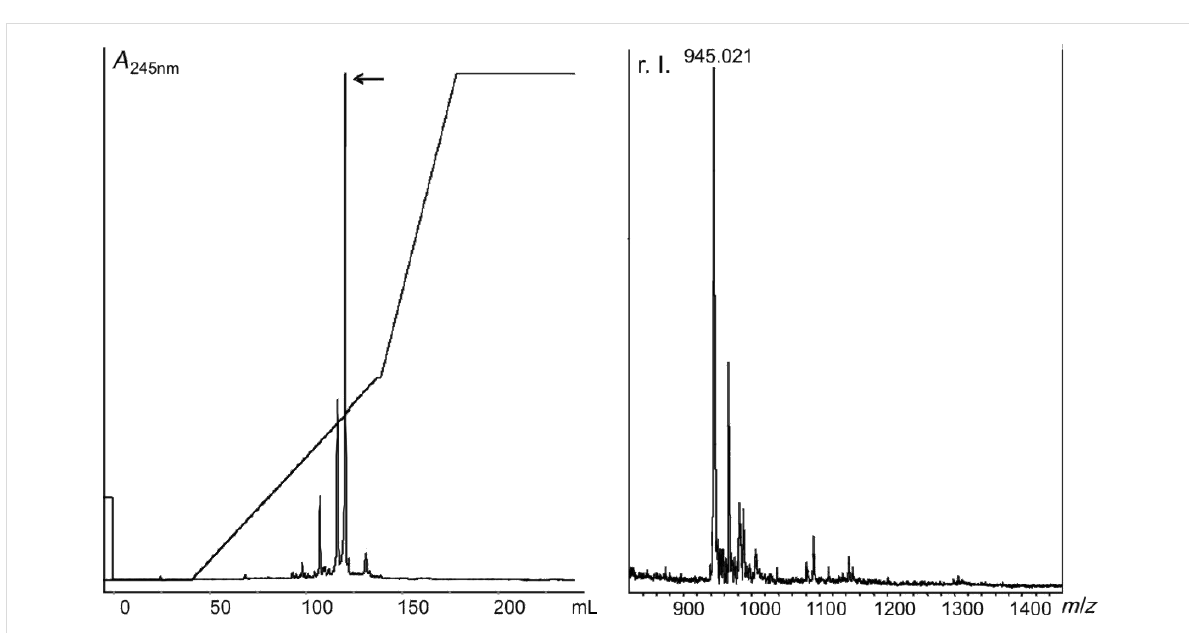
Figure 6: A) Reversed-phase HPLC purification of 1 after complete deprotection of 16. A represents the absorption at 254 nm. The fraction indicated by an arrow was collected and analyzed by MALDI mass spectrometry. B) MALDI-spectrum of the pooled collected fractions. The peak at 945.021 (calcd. mass: 944.40 g/mol [M + H] + ) corresponds to the cytidine derivative 1 . r.I. represents the relative intensity.